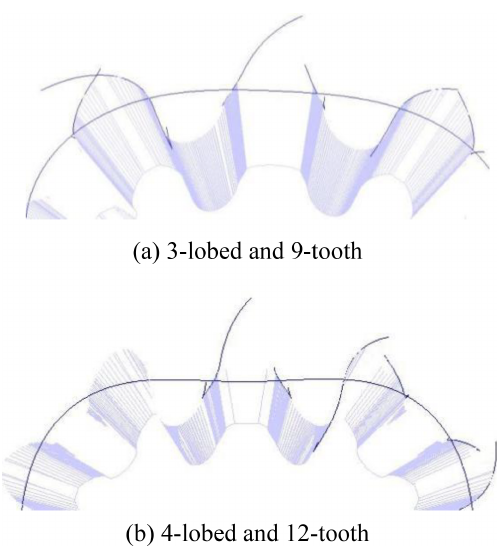
Figure 8. Tooth profile curve